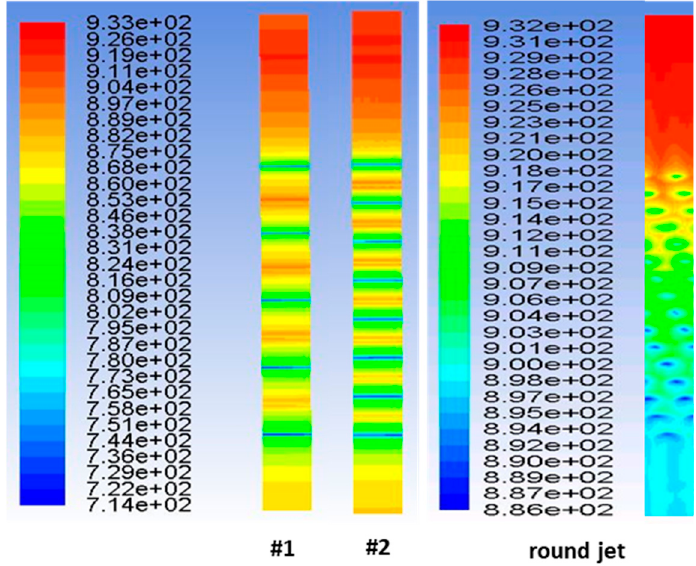
Figure 22. Temperature contours on the tape for the different cooling configurations.